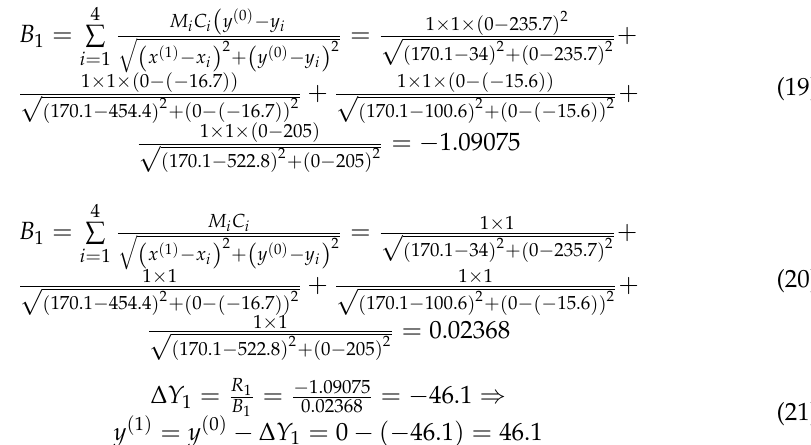
Table 1. Input data for calculating the DC location, DC[ x ( opt ) ; y ( opt ) ], point coordinates, unit quanti- ties, unit prices, and selected accuracy.